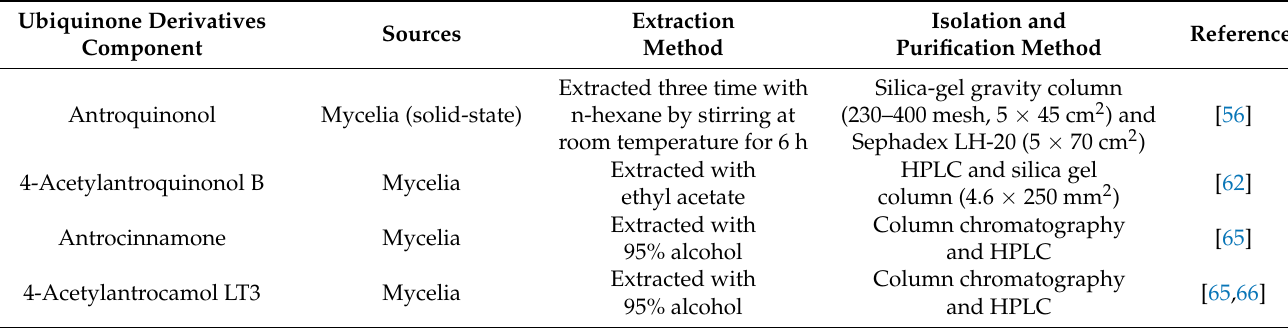
Table 3. Preparation procedures of ubiquinone derivatives from A. cinnamomea in recent